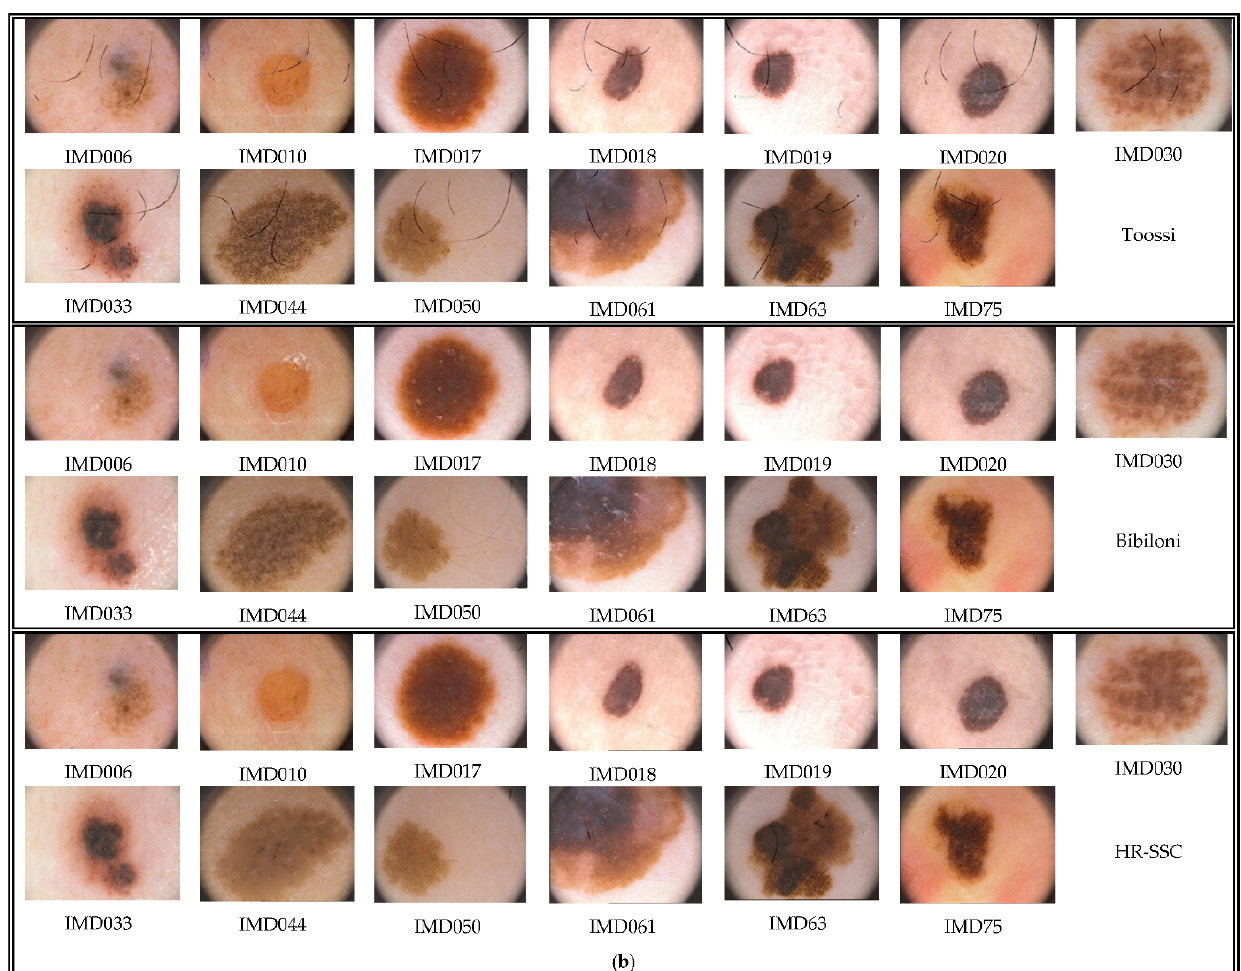
Figure 10. ( a ) Results of methods Lee, Xie, Abbas, Huang available in [37], rows 1–4, on H13GAN-data. ( b ) Results of methods Toossi, Bibiloni available in [37], rows 1–2, and results of HR-SSC, row 3, on H13GAN-data.